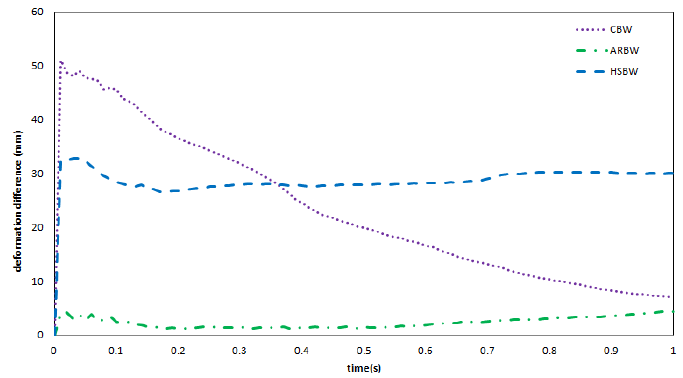
ff erence history of blast Figure 12. Deformation difference history of blast walls. Figure 12. Deformation di Figure 12. Deformation difference history of blast walls.